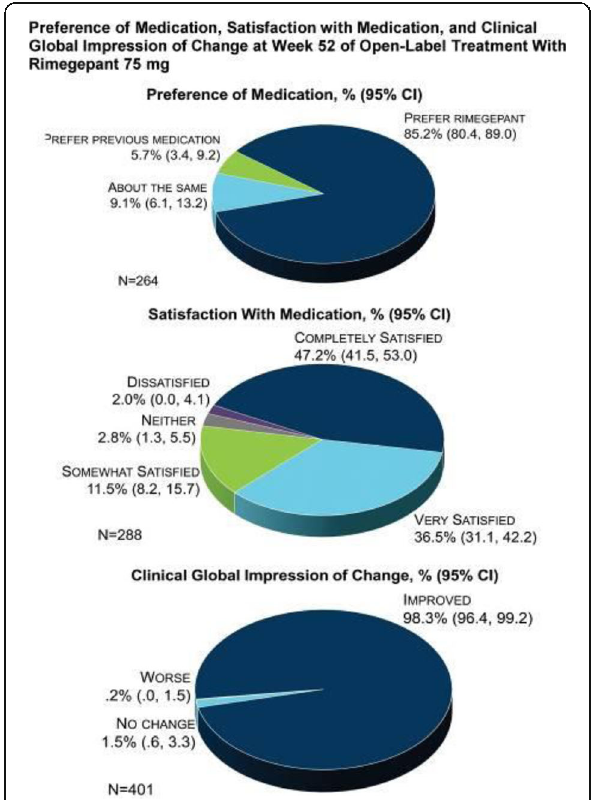
Fig. 1 (abstract 123). See text for